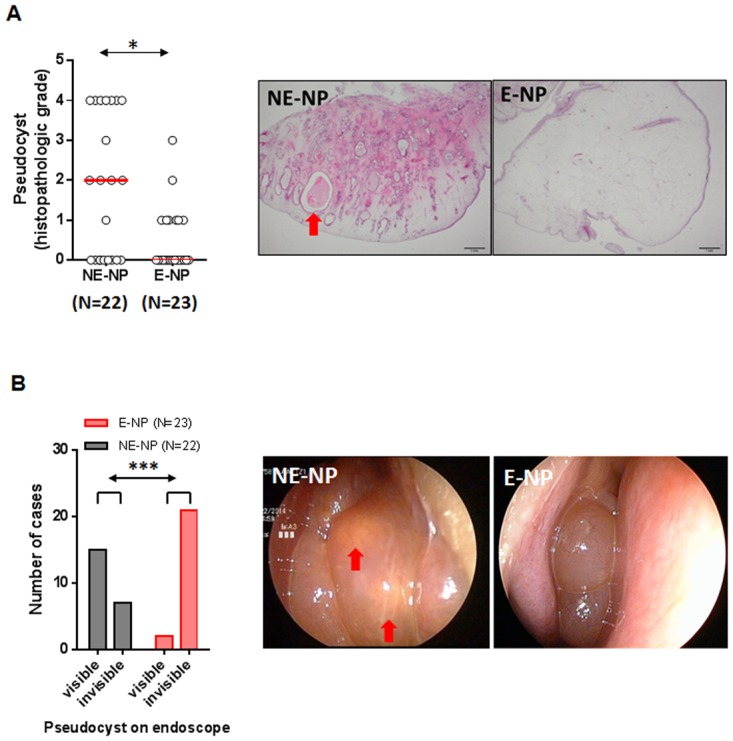
Distinctive histological features of non-eosinophilic CRSwNP patients.
(A) Comparison of the proportion of total NP tissue area occupied by pseudocysts in different endotypes of CRSwNP and representative hematoxylin/eosin staining images of a pseudocyst (red arrow) within the epithelial layer from non-eosinophilic NP tissues (40×) (B) Comparison of a yellowish spot in NP tissue between non-eosinophilic and eosinophilic CRSwNP patients and representative images of a yellowish spot (red arrow) found on endoscopy in a non-eosinophilic CRSwNP patient. (*p<0.05, **p<0.01, and ***p<0.001). Data represent medians. E-NP, eosinophilic nasal polyp; NE-NP, non-eosinophilic nasal polyp.